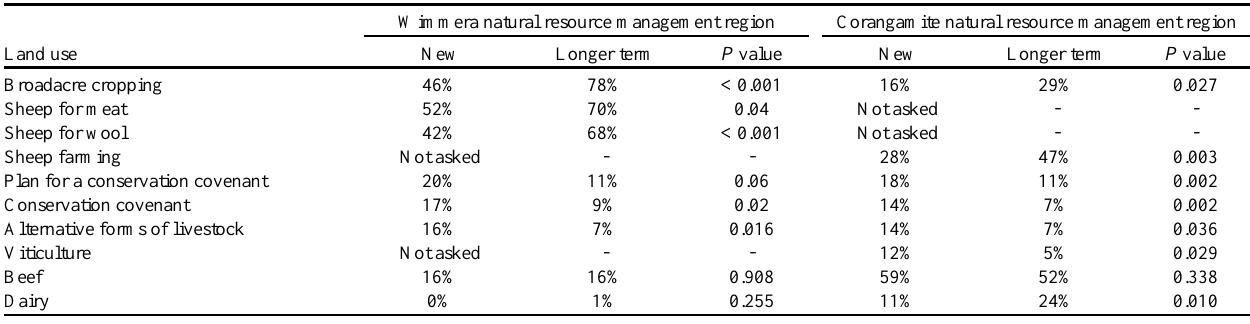
Table 5 . Comparing newer (Wimmera region: n = 68–79; Corangamite region: n = 82–85) and longer term (Wimmera region: n = 314–323; Corangamite region: n = 331–342) landholders: land use. ( n denotes the number of respondents. Each item had a different number of respondents owing to missing values; these are indicated by the ranges in n